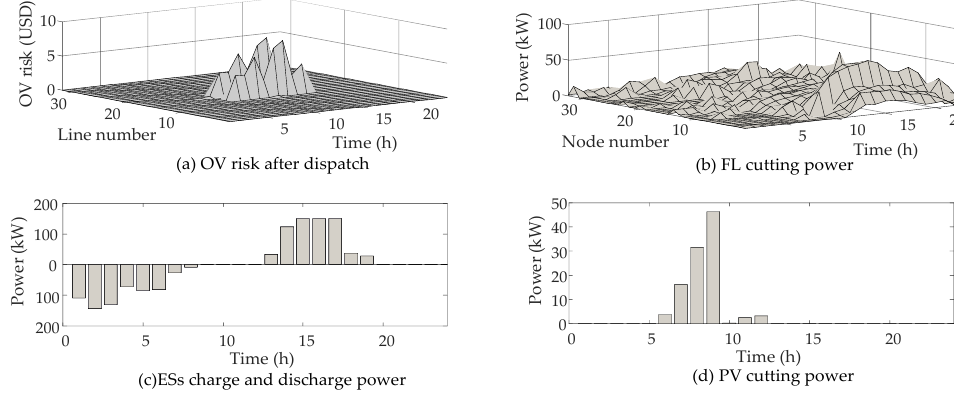
Figure 9. Optimized OV risks and dispatch results.